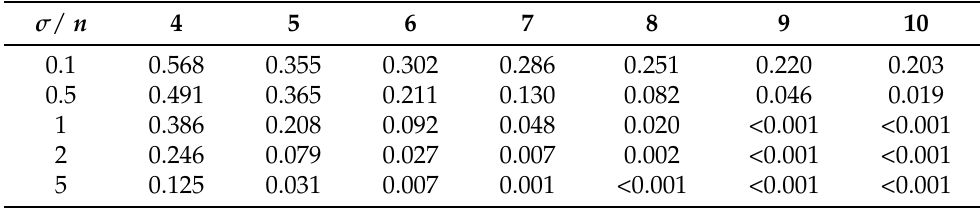
Table 2. Differences estimated probabilities minus lower bounds in Theorem 10 computed in our computational experiments shown in Table 1.